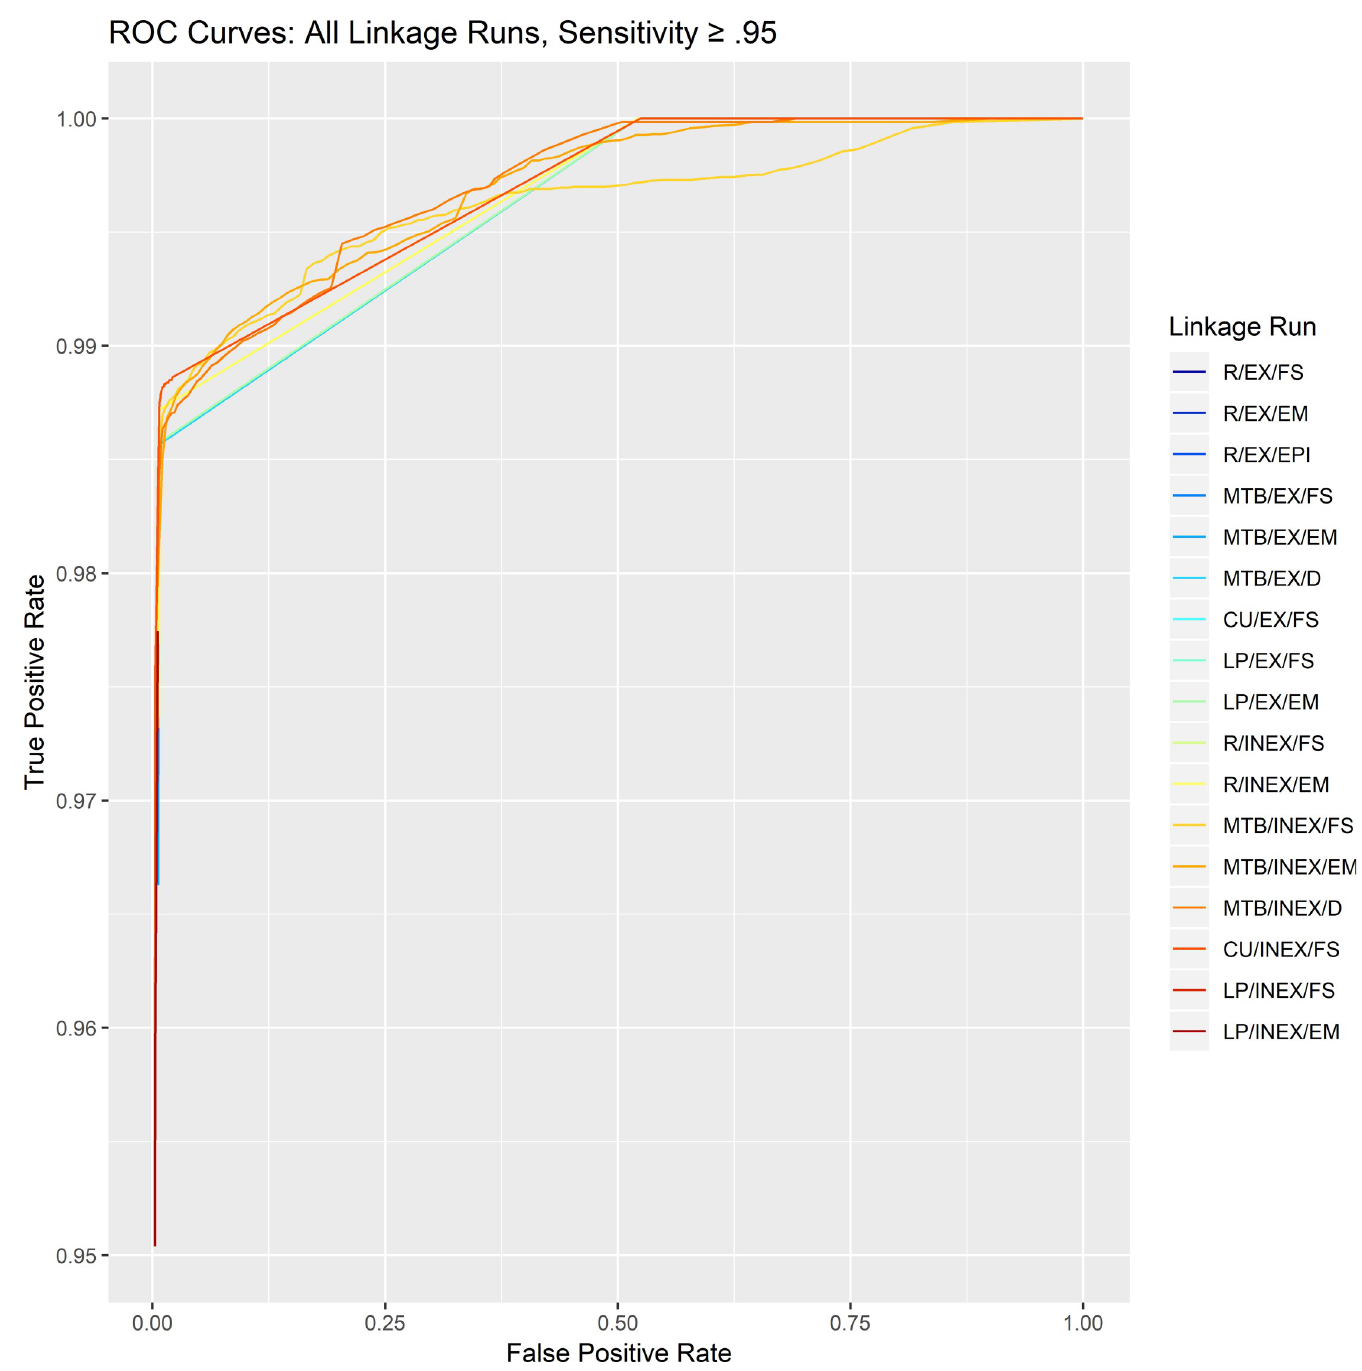
Fig 2. Receiver operating characteristic curves for all linkage runs. EX, exact string matching; INEX, inexact string matching; R, R package; MTB, Merge ToolBox; CU, Curtin University Probabilistic Linkage Engine; LP, Link Plus; LP, Link Plus; FS, probabilistic, Fellegi-Sunter; EM, probabilistic, expectation-maximization; EPI, probabilistic, EpiLink; D, deterministic. Curves are limited to values of sensitivity equal to or exceeding 0.95 for clarify. Full ROC curves are presented in Fig D in S1 File.